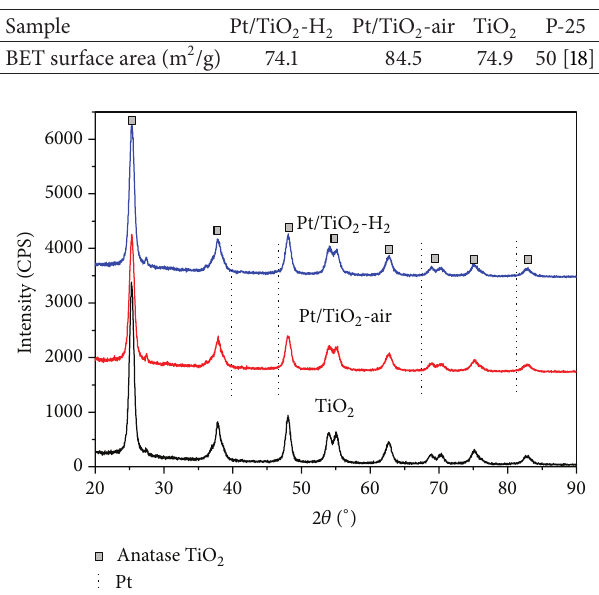
Figure 2: XRD patterns of the Pt/TiO 2 and TiO 2 catalysts.